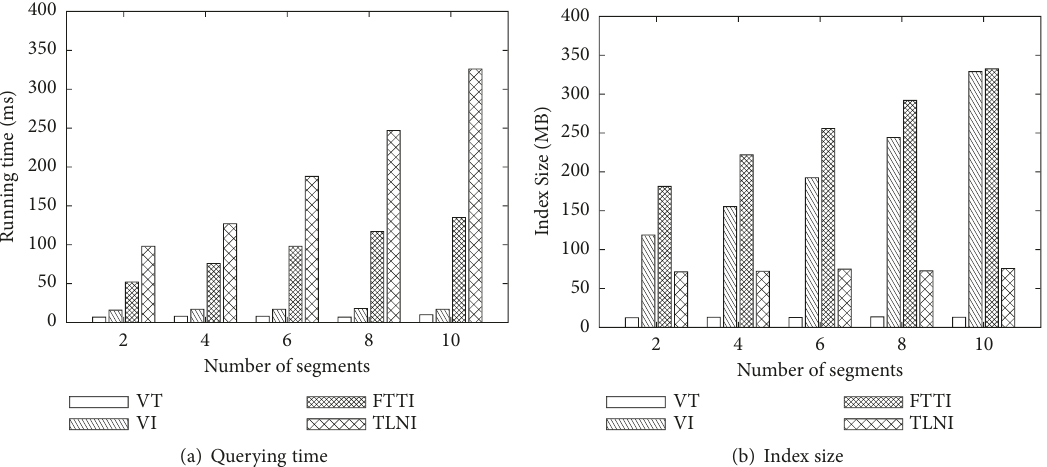
Figure 8: Impact of the number of piecewise interval of time function.